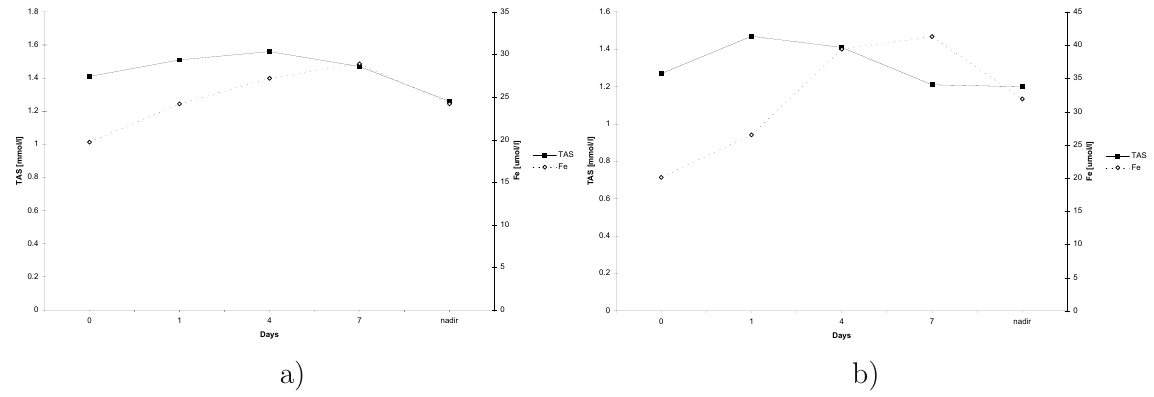
Fig. 2 Comparison between the changes in TAS and total serum iron average values in AML patients during chemotherapy